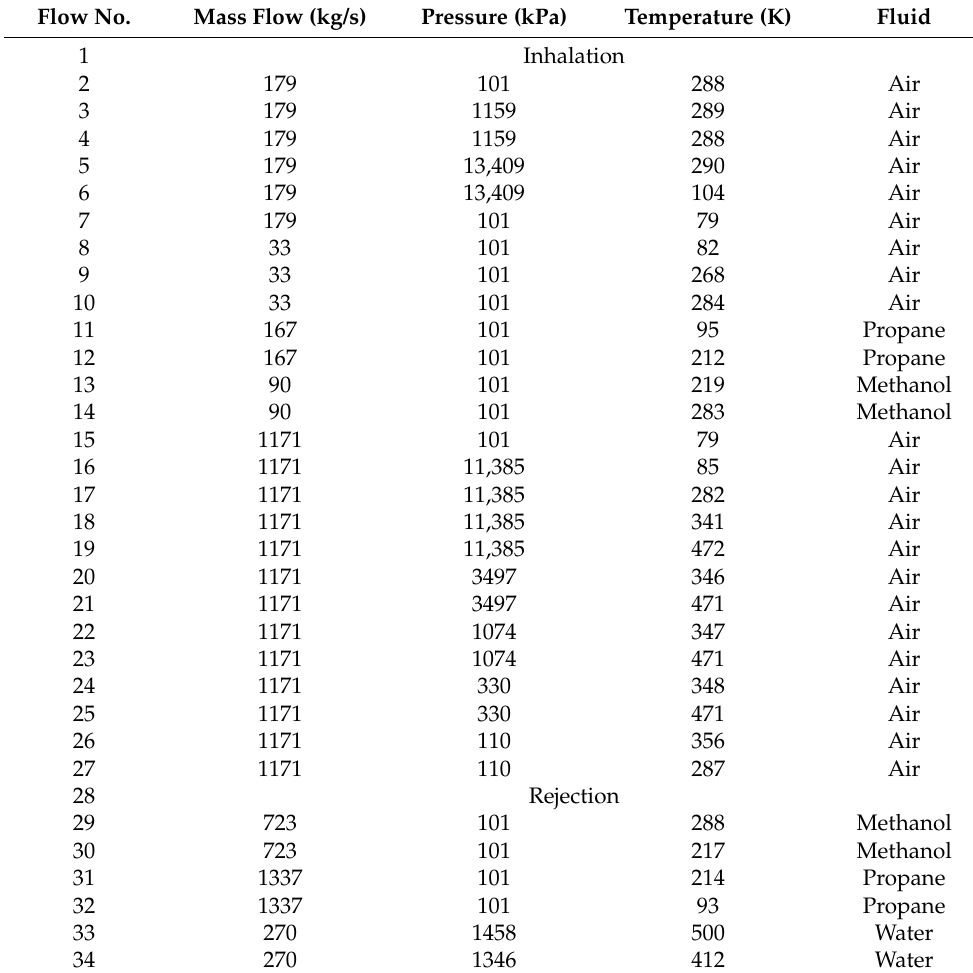
Table 8. The main steam parameter for APR1400 integrated LAES. Flow